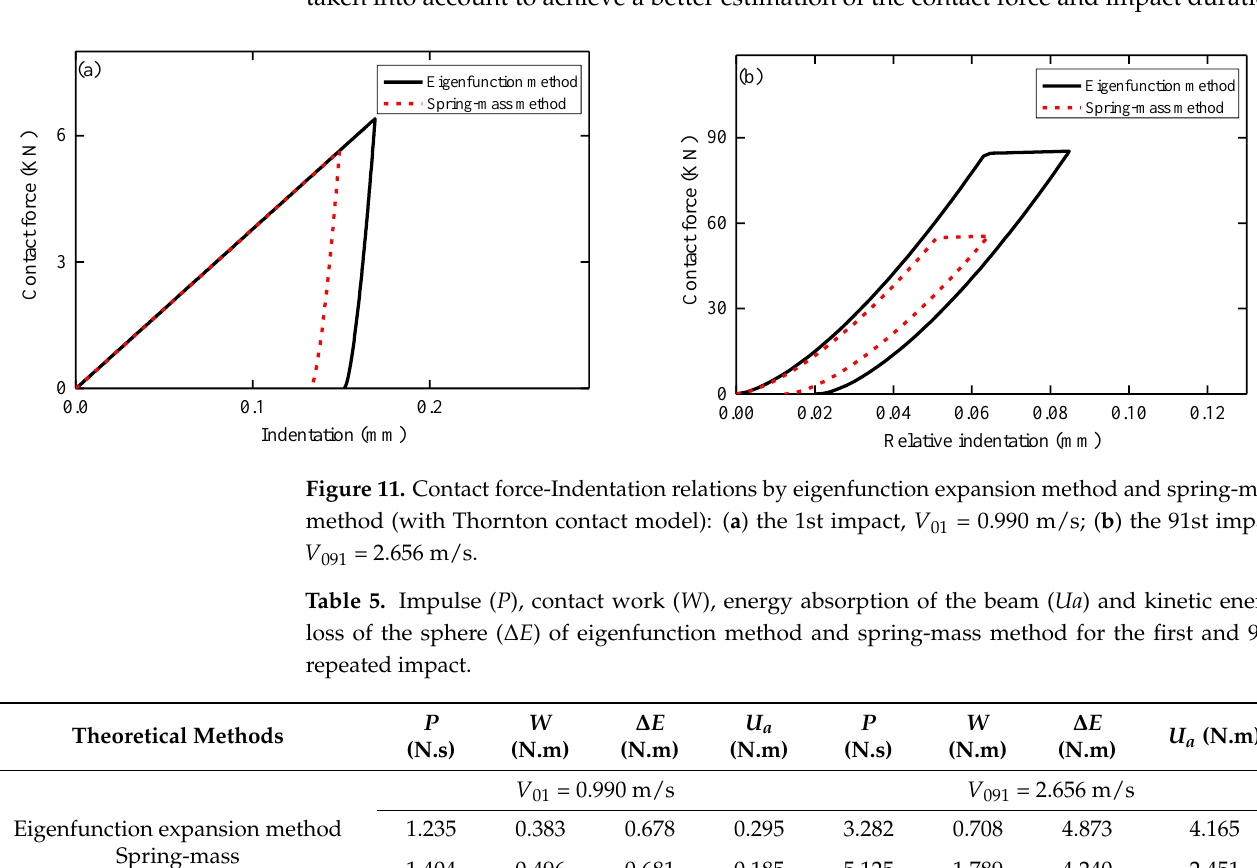
duration of spring-mass method model are 53.30% higher and 8.99% shorter relative to Figure 10. Contact force responses by eigenfunction expansion method and spring-mass method (with Thornton contact model): ( a ) the 1st impact, V 01 = 0.990 m/s; ( b ) the 91st impact, V 091 = 2.656 m/s. taken into account to achieve a better estimation of the contact force and impact duration.